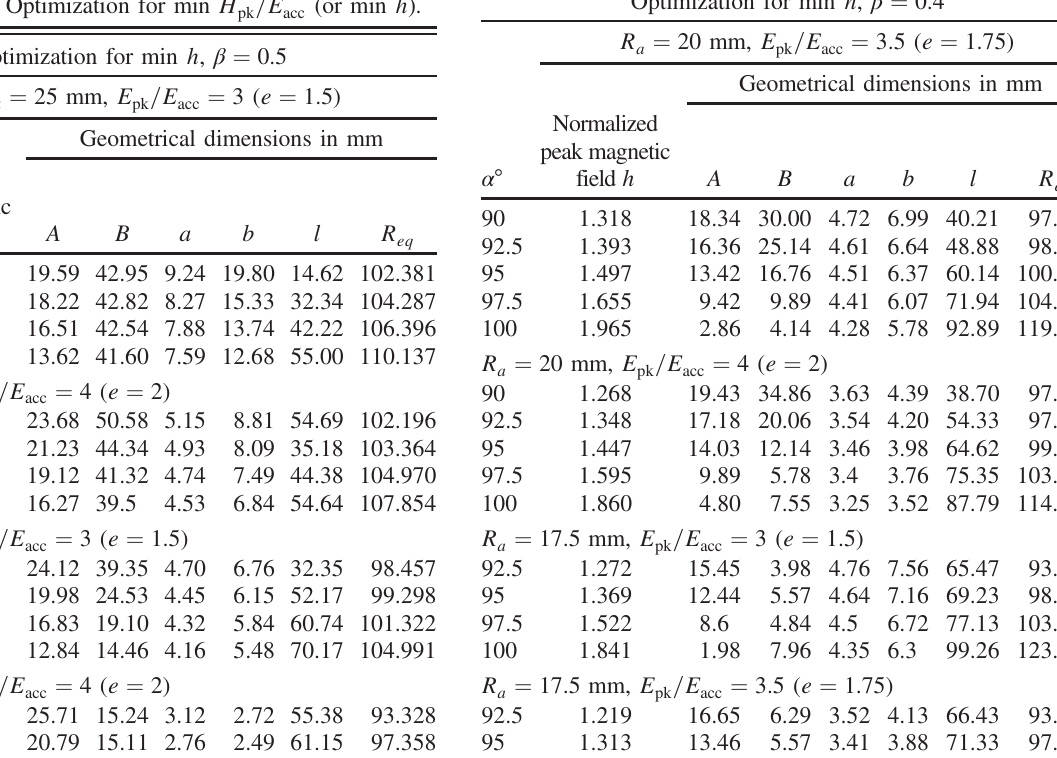
FIG. 23. Normalized magnetic peak field for different angles of the wall slope for β ¼ 0 . 5 . Points a, b, and c, also as d, e, f are shown for comparison with data from [16], see text. TABLE VII. Values of h ¼ H optimized inner cell (two elliptic arcs and a straight segment) vs the slope angle α . Optimization for min H